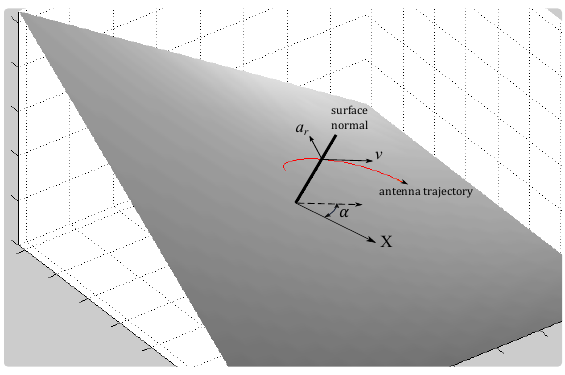
Figure 5. Input (query) of skiing pose prediction model: radial acceleration of the antenna a v and the angle α between the local skiing direction and X -axis of the r , absolute velocity ski slope surface normal.